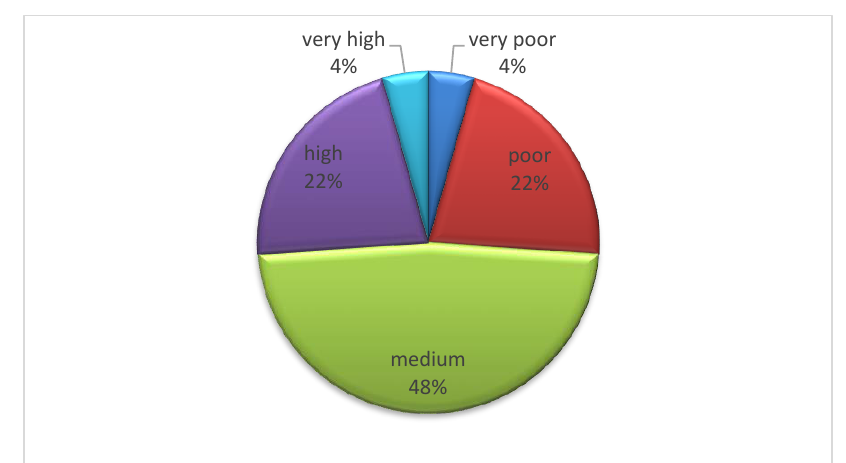
Figure 4. Ibnu Rusdy Students’ HOTS based on Judgment and Critical Thinking Indicator in Percentage